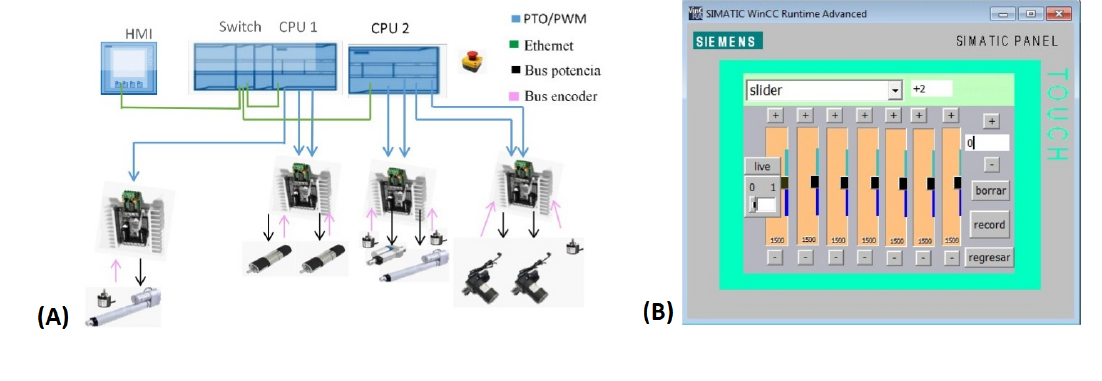
Figure 9. ( A ) Electronic diagram of the ERMIS ( B ) The interface for the first implementation.